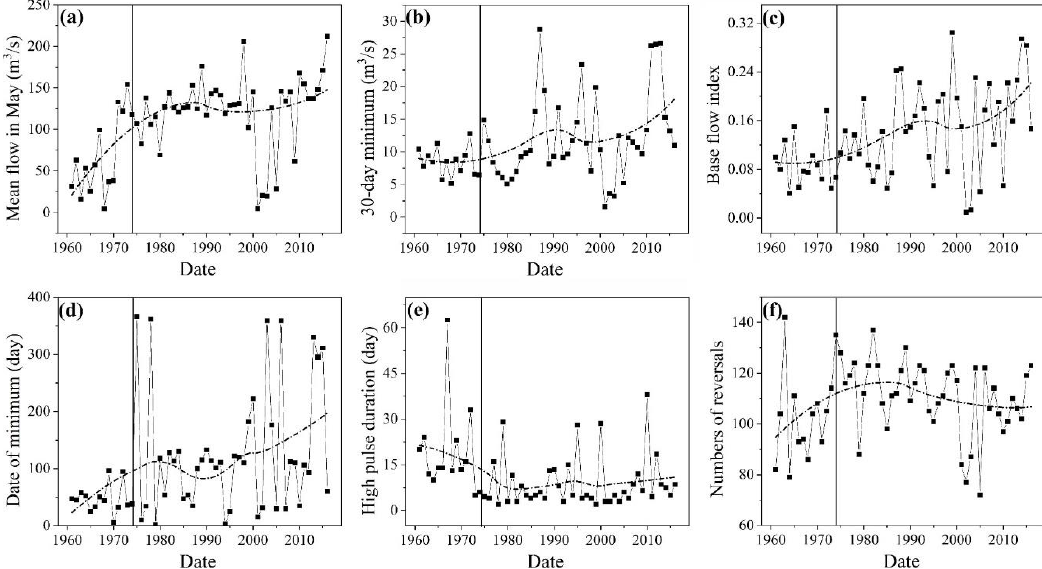
Figure 7. Temporal variation in the ERHIs: ( a ) mean flow in May; ( b ) 30-day minimum; ( c ) base flow index; ( d ) date of minimum; ( e ) high pulse duration; and ( f ) number of reversals. The dotted line is the Loess function fitting curve, and the black vertical line is the date when the SWR completed.